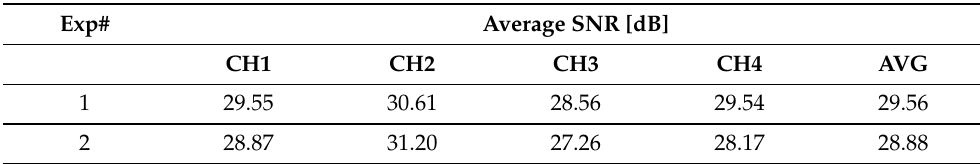
Table 1. Average SNR values for channels and experiments.